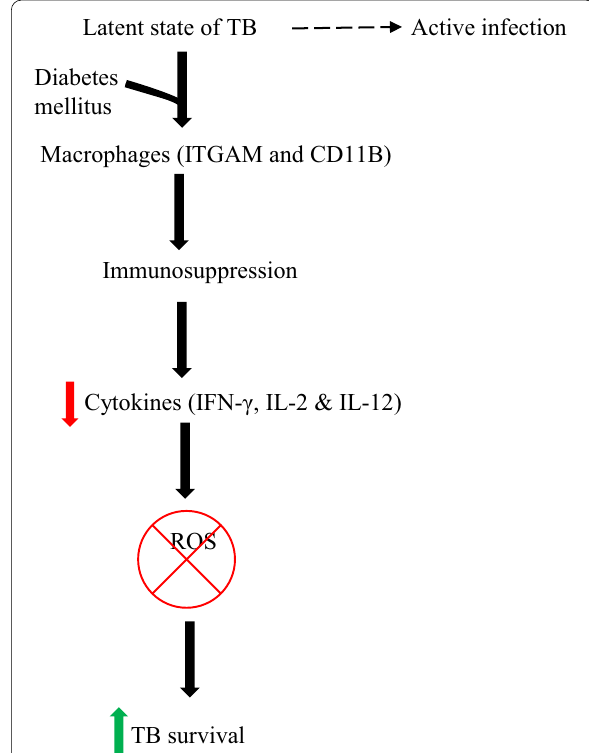
Fig. 9 Schematic representation that promotes TB infection during diabetes mellitus. TB is a latent illness that can progress to active TB (dotted arrow); in diabetic conditions, during immunosuppression state, the patient is more likely to acquire active tuberculosis (bold